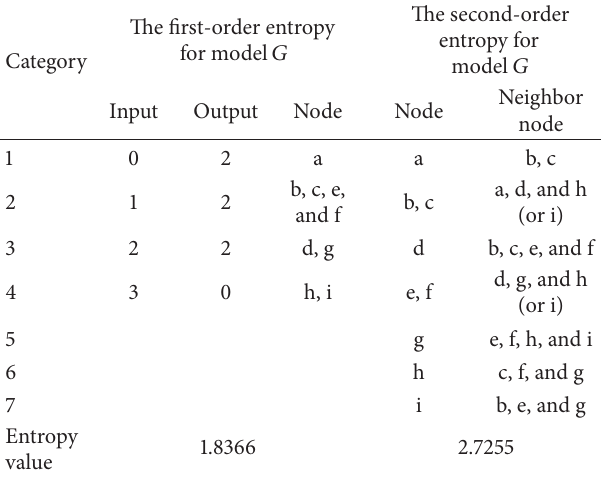
Table 1: Classification and calculation for the first- and second- order entropy of model 𝐺 .